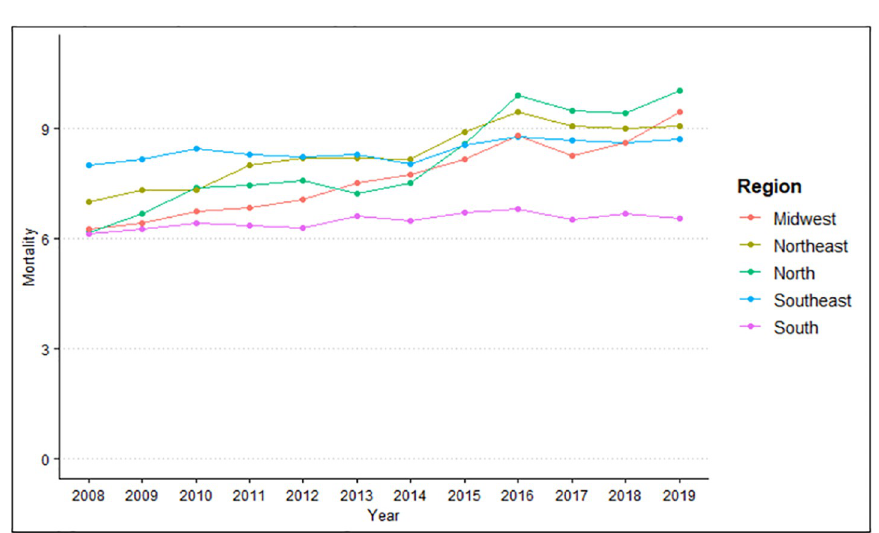
Fig 9. Mortality rate from cardiovascular diseases according to region of residence in the period from 2008 to 2019. Source: Ministry of Health–Hospital Information System of the Unified Health System (SIH/SUS) 2021.